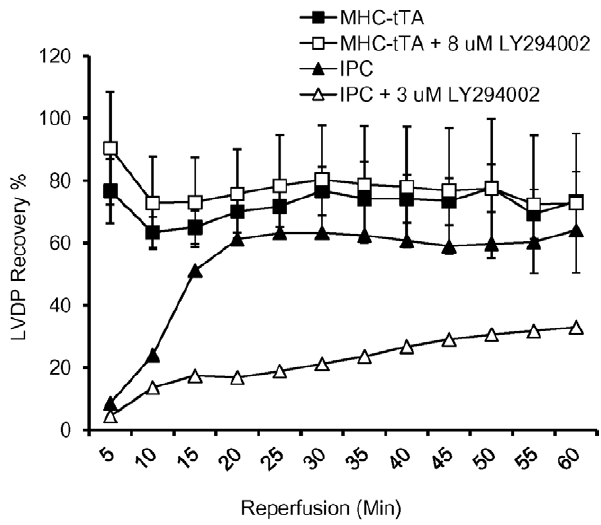
Figure 2. Effect of PI3K inhibition on the protection against I/R injur in a -MHC-tTA hearts. Administration of LY294002 did not abolish the protective effect seen in a -MHC-tTA hearts however it did abolish protection imparted by IPC. (N=5 for a -MHC-tTA and N=3 for a -MHC-tTA + 8 m M LY294002, p , 0.05).